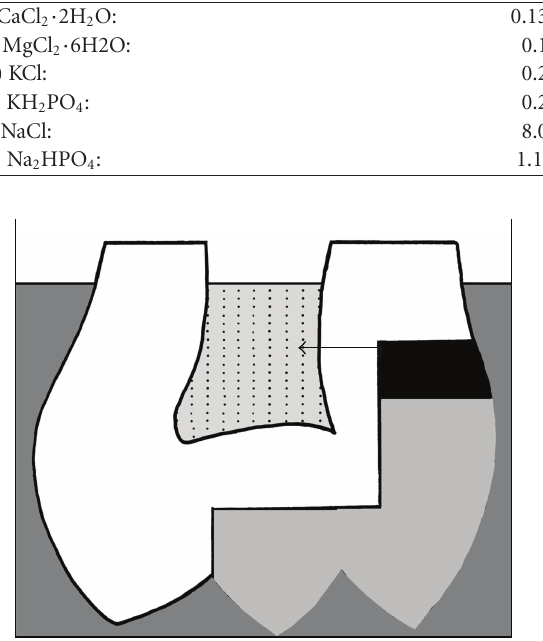
Figure 1: The glucose di ff usion test. The tooth, with the lining ma- terial (in black) and the composite (in grey), was placed upside- down in 1M glucose (dark grey), with the level of the solution below the tooth apex. Glucose di ff used through the dentin-material interface and reached the pulpal space filled with water (dotted grey). The di ff usion pathway is depicted by the